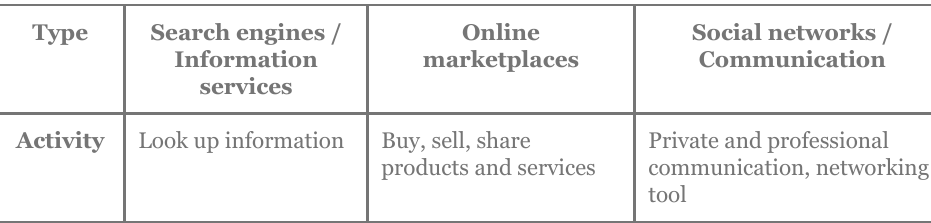
Table 1: Taxonomy of online platforms. Main online platform types based on consumer